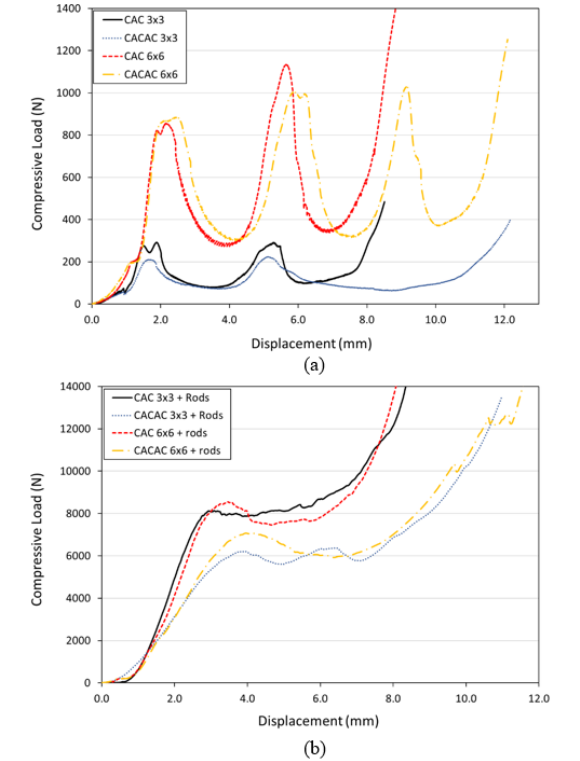
Figure 14: Load-displacement data of 3 cm × 3 cm and 6 cm × 6 cm panels with CAC and CACAC stacking configurations: (a) panels without rods and (b) panels with rods.